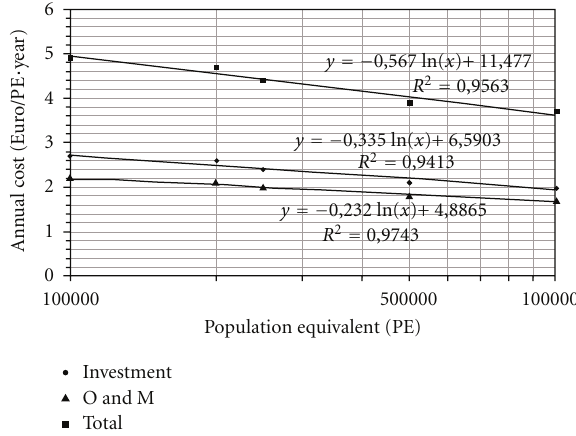
Figure 2: Change in annual cost values for